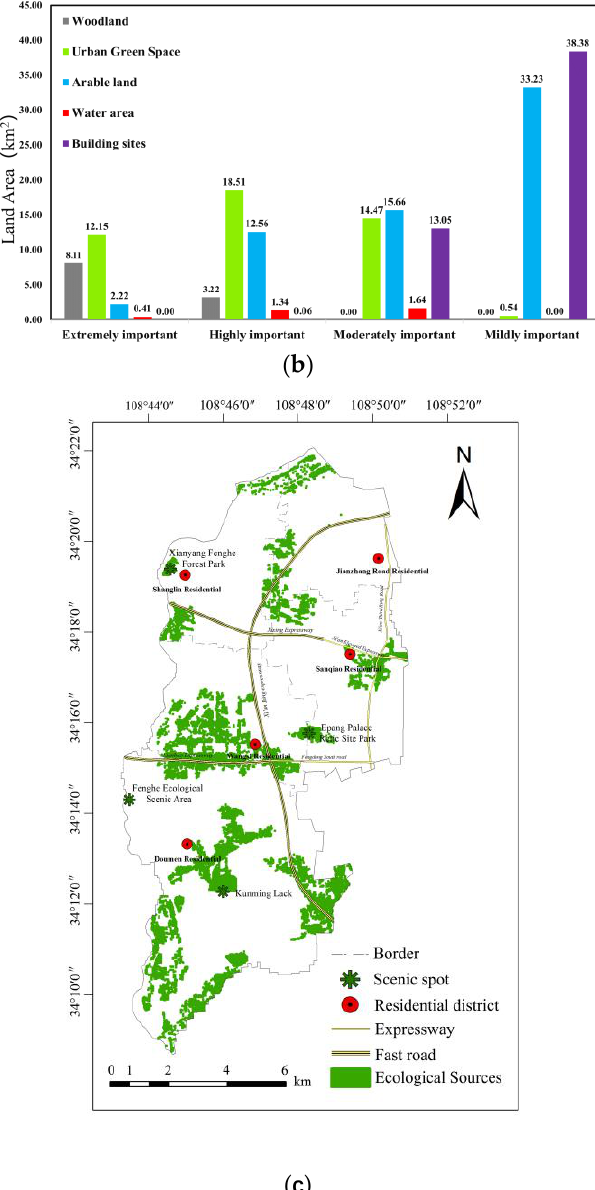
Figure 9. ( a ) Analysis of the grades of ecological land under different types of demand; ( b ) analysis of the types of extremely important land; ( c ) ecological sources.